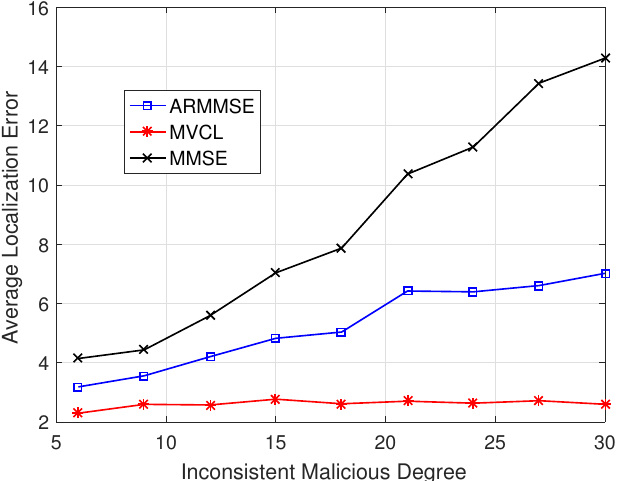
Figure 18. Average localization error with inconsistent malicious degree ζ ( n = 80, m = 20, R = 30, k = 4, η =